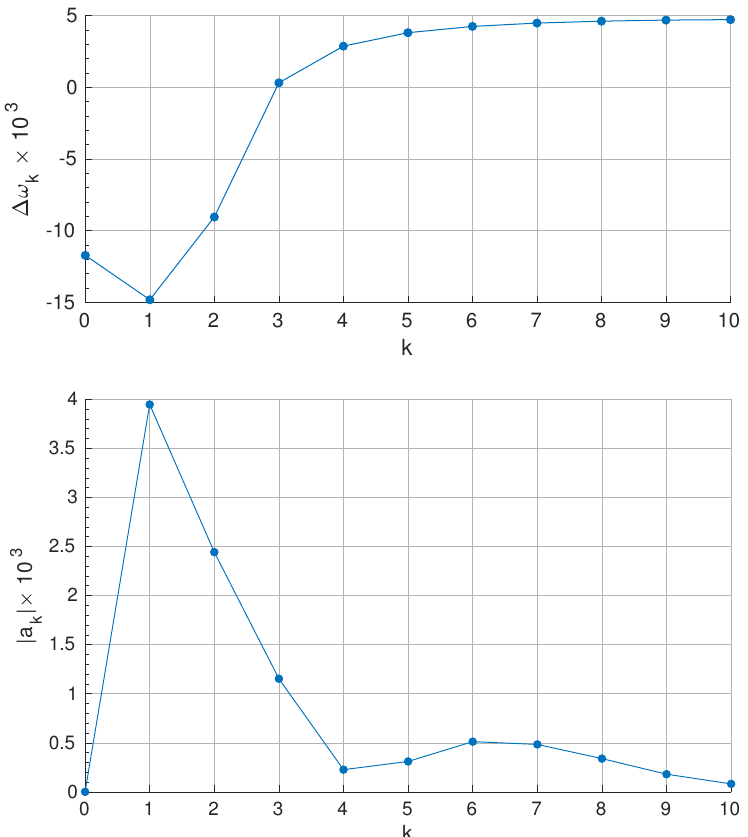
Figure 12. ( Top ): relative frequency deviations for the first modal family of Rotor B. ( Bottom ): corresponding influence coefficients.